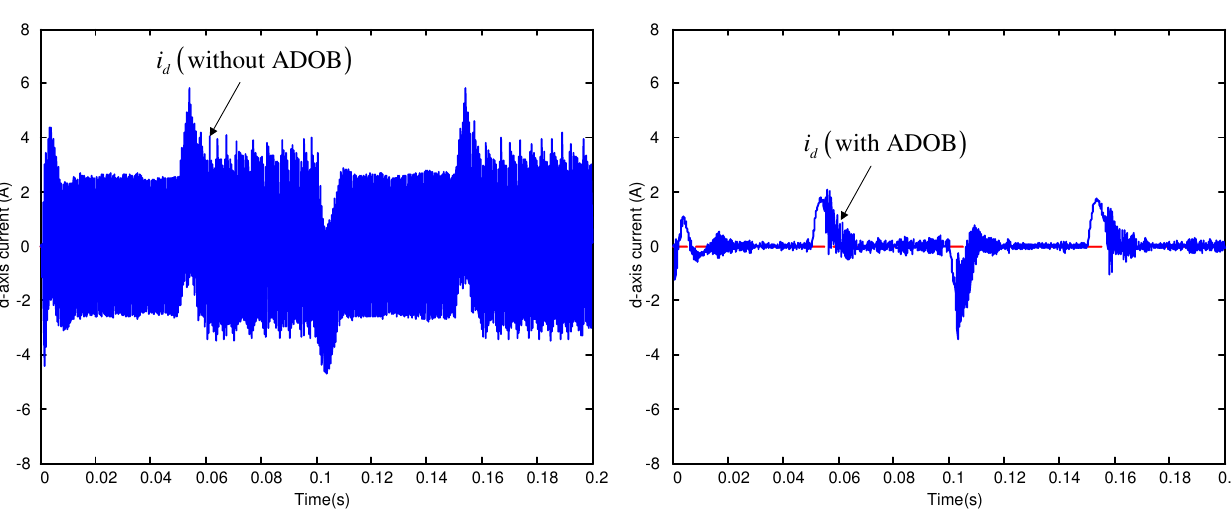
( Left ) d -frame current response without the adaptive disturbance observer (ADOB); ( Right ) d -frame current response with